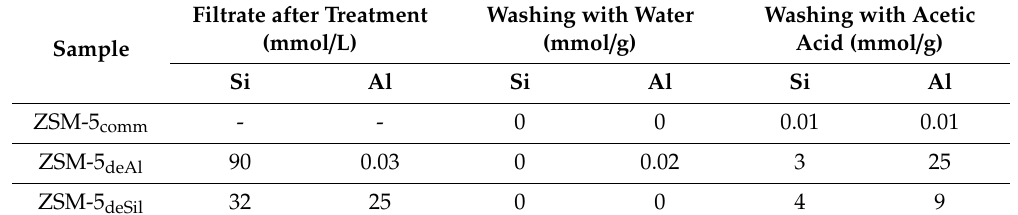
Table 2. The Al 3 + and Si 4 + contents after treatment and washing. Table 2. The Al 3+ and Si 4+ contents after treatment and washing.